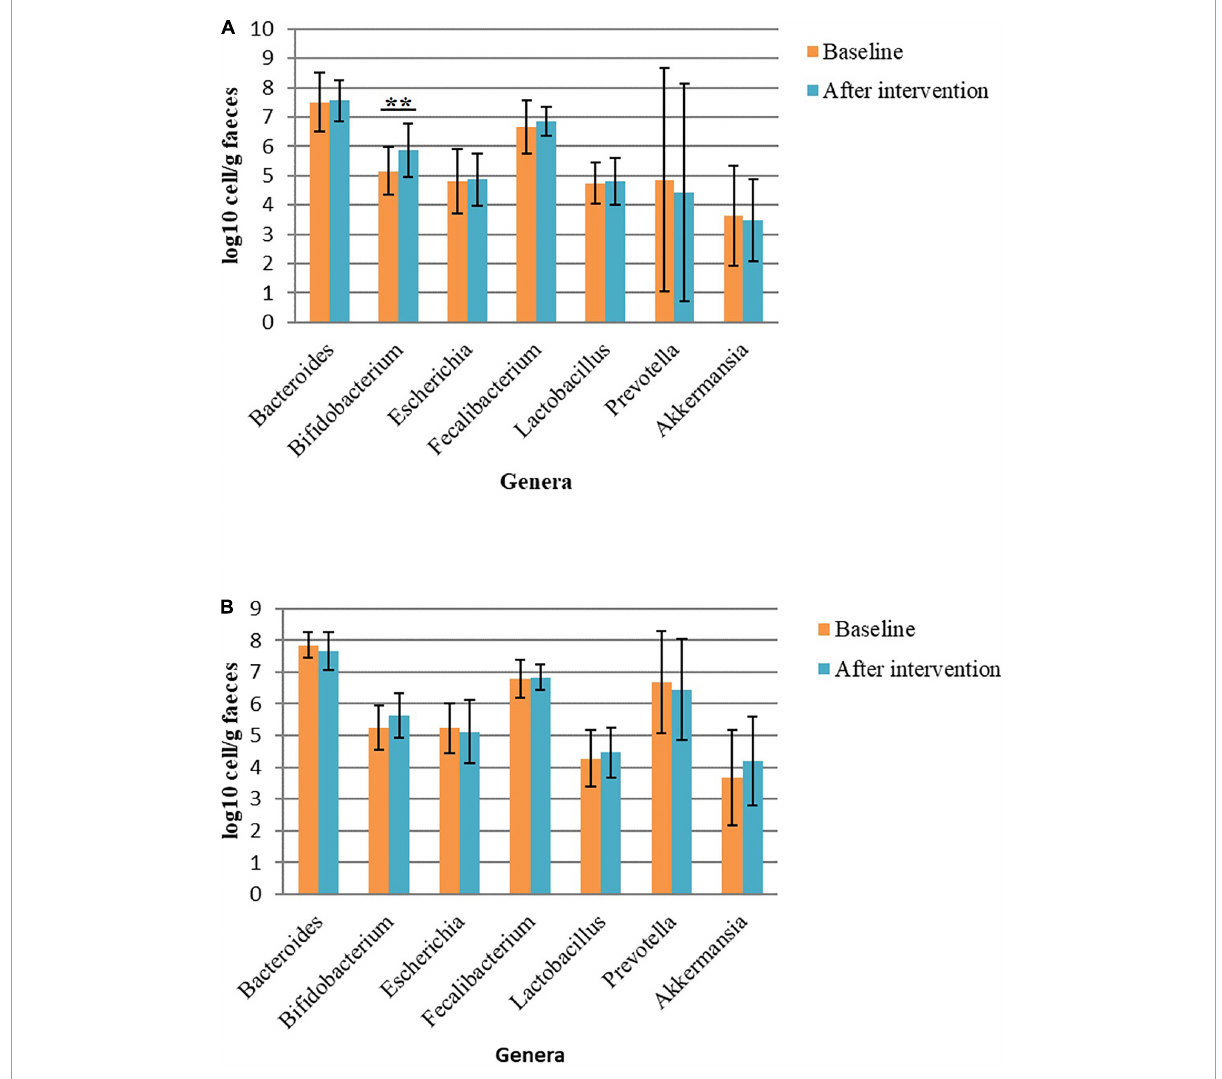
FIGURE2 Bacterial load in fecal samples before and after intervention in obese women. (A) Bacterial load before and after Allium intake. (B) Bacterial load before and after placebo intake. Comparisons were done using paired samples t -test or Wilcoxon test. *Significant difference within groups. ** p -value <